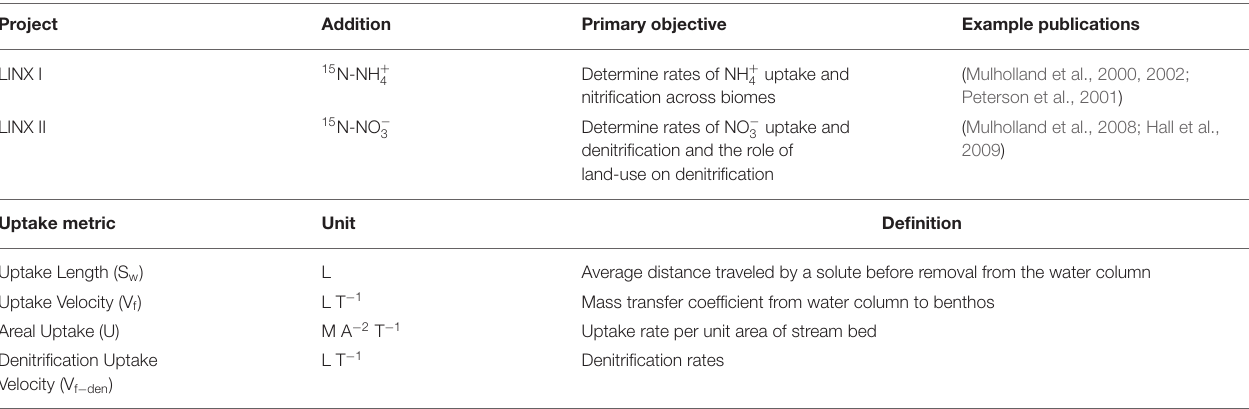
TABLE 1 | Summary of LINX I and LINX II projects along with definitions of key uptake